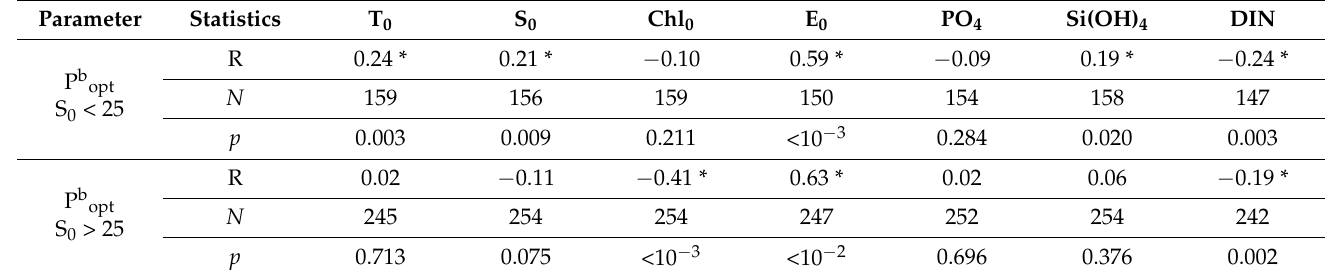
Table 7. The correlation matrix between the log-transformed optimal assimilation number